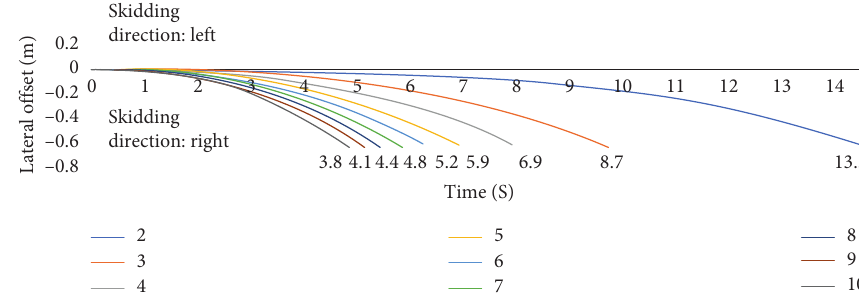
Figure 10: Impact of the water depth difference on the lateral slip time.